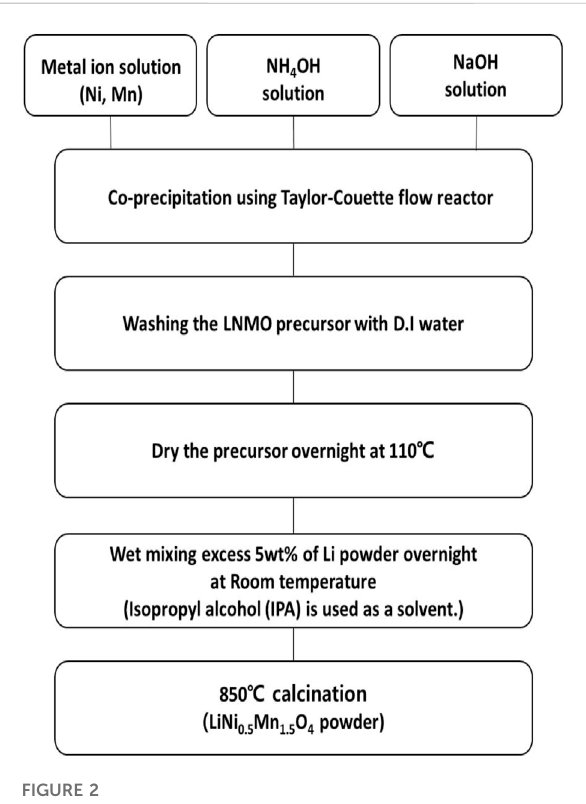
Flow chart of LiNi 0.5 Mn 1.5 O 4 cathode material